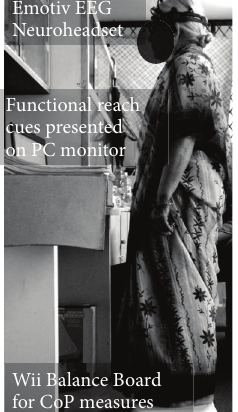
Figure 1: An illustration of the experimental